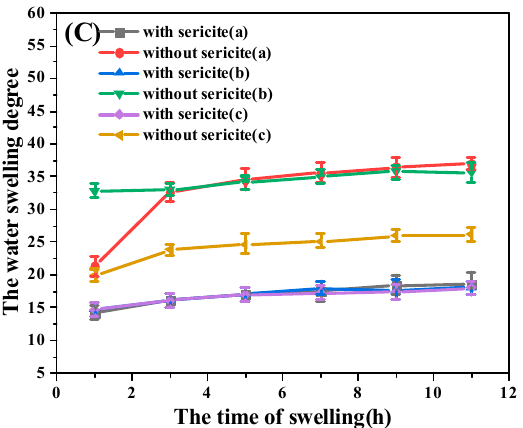
Figure 5. Swelling properties of the plugging agent in different solutions with different salt concentrations at room temperature. ( A ) NaCl solution: (a) 10,000 mg/L; (b) 30,000 mg/L; (c) 50,000 mg/L. ( B ) CaCl 2 solution: (a) 1000 mg/L; (b) 5000 mg/L; (c) 10,000 mg/L. ( C ) MgCl 2 solution: (a) 1000 mg/L; (b) 3000 mg/L; (c) 5000 mg/L.